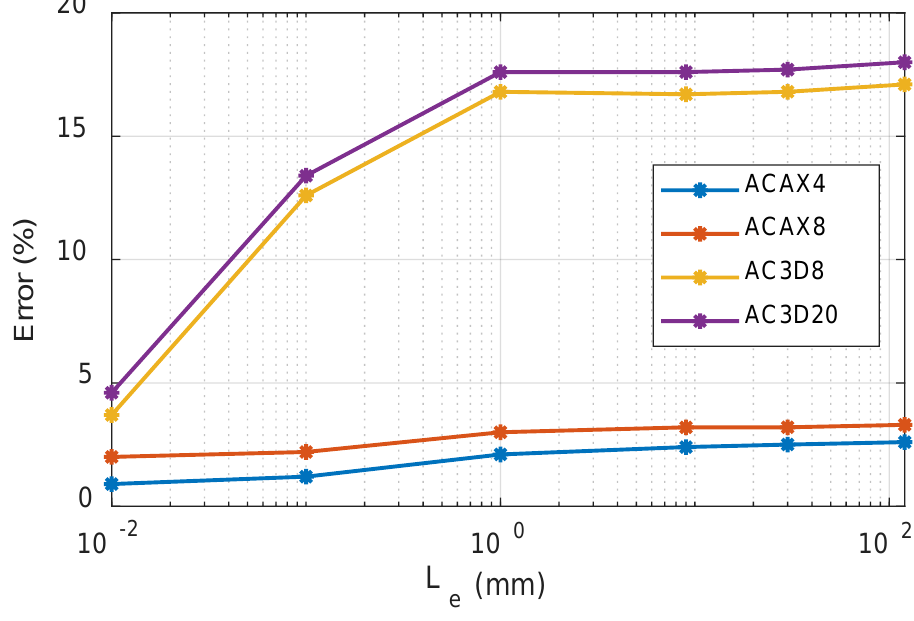
Figure 14. Relationship between the Acoustic speed error and the element type/element size.